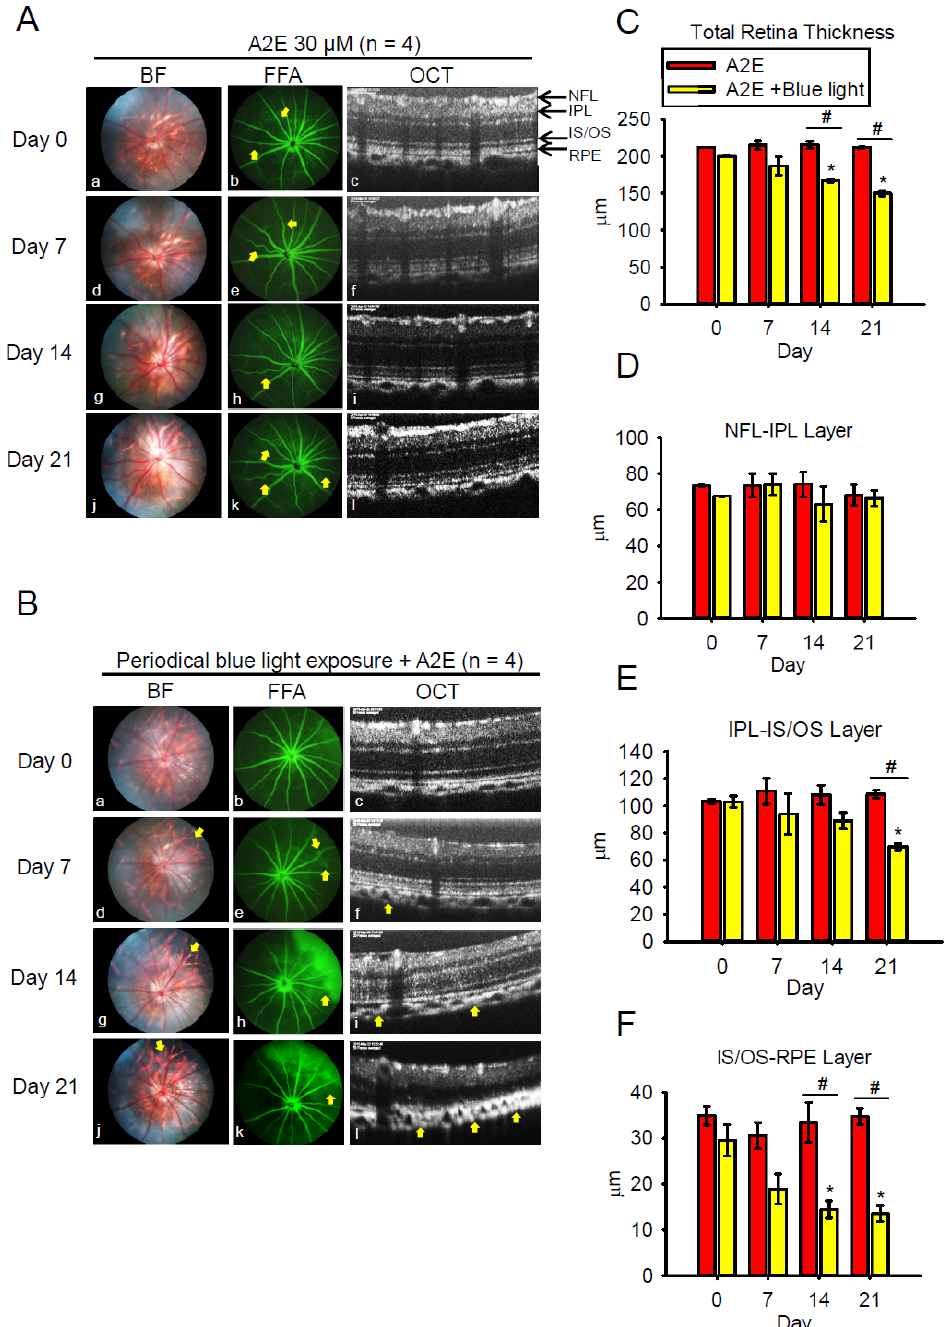
Figure 6. Blue light exposure causes retinal damage in A2E-treated brown Norway (BN) rats. ( A , B ) Representative ocular images of the A2E-treated group and A2E + blue light-emitting diode (LED) light (BLL) co-treated group from left to right showing the results of bright field (BF), fundus fluorescein angiography (FFA), and spectral-domain optical coherence tomography (SD-OCT) on days 0, 7, 14, and 21. Fluorescein angiography was performed immediately after intravenous injection of 15 mg / kg sodium fluorescein for 30 s. ( C – F ) Quantification of data including total retinal thickness, nerve fiber layer-inner plexiform layer (NFL-IPL), IPL-inner segment / outer segment (IS / OS) layer, and IS / OS-retinal pigment epithelial (RPE) layer in A (red bars) and B (yellow bars). Results from 4 independent experiments are shown (N = 4). * p < 0.05 was considered statistically significant compared to day 0. # p < 0.05 was considered statistically significant compared to the A2E-treated group on the same